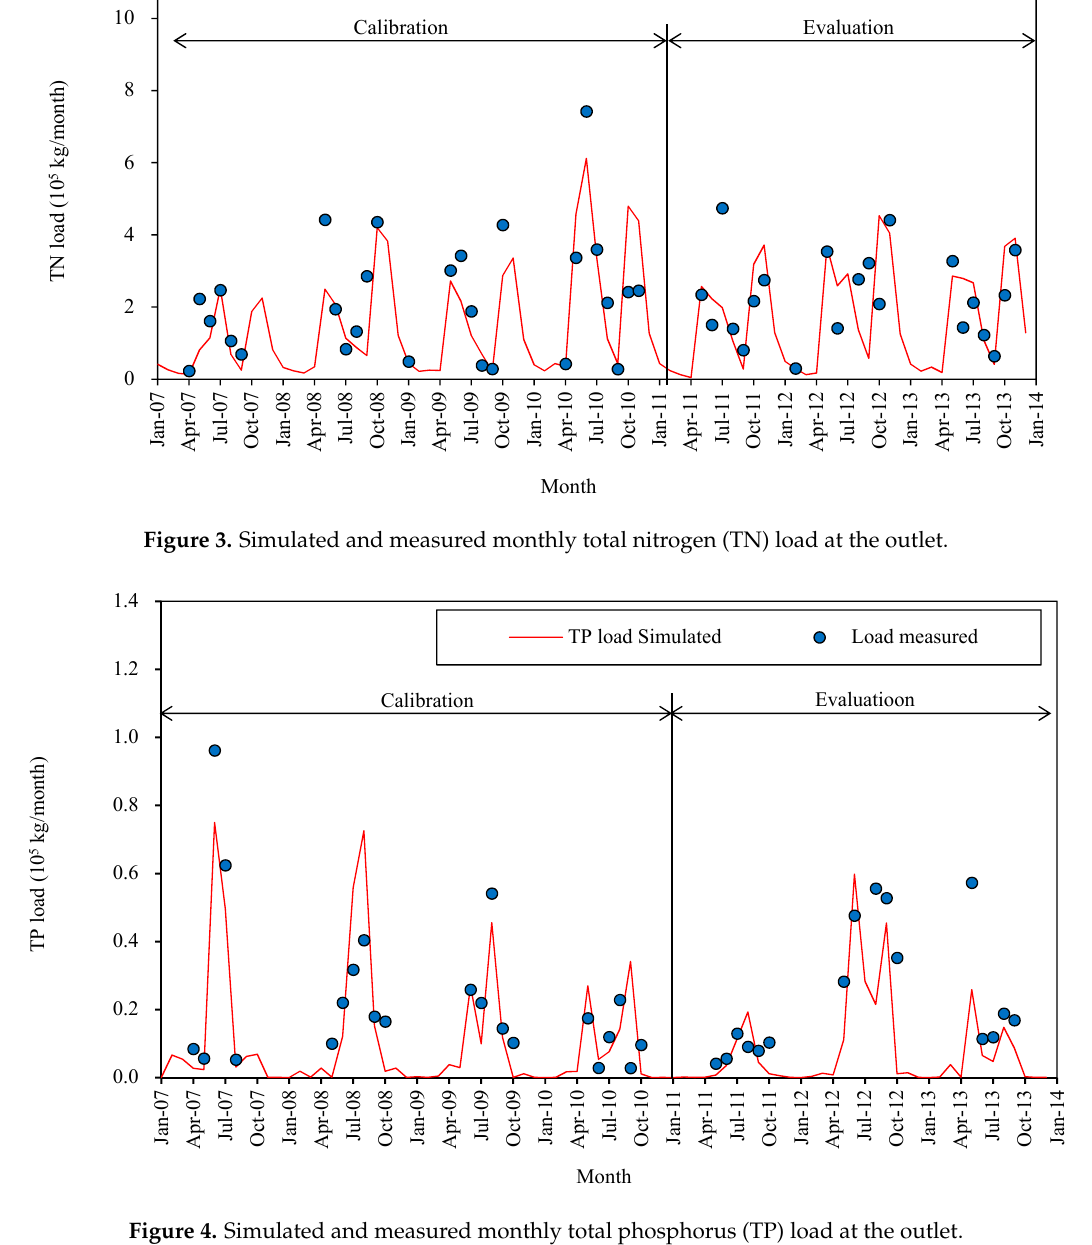
Figure 4. Simulated and measured monthly total phosphorus (TP) load at the outlet.